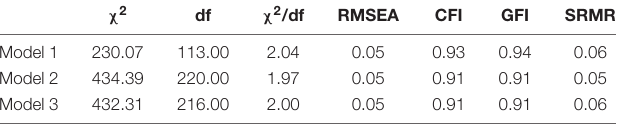
TABLE 2 | Fit Indexes of Model 1, 2 and 3.